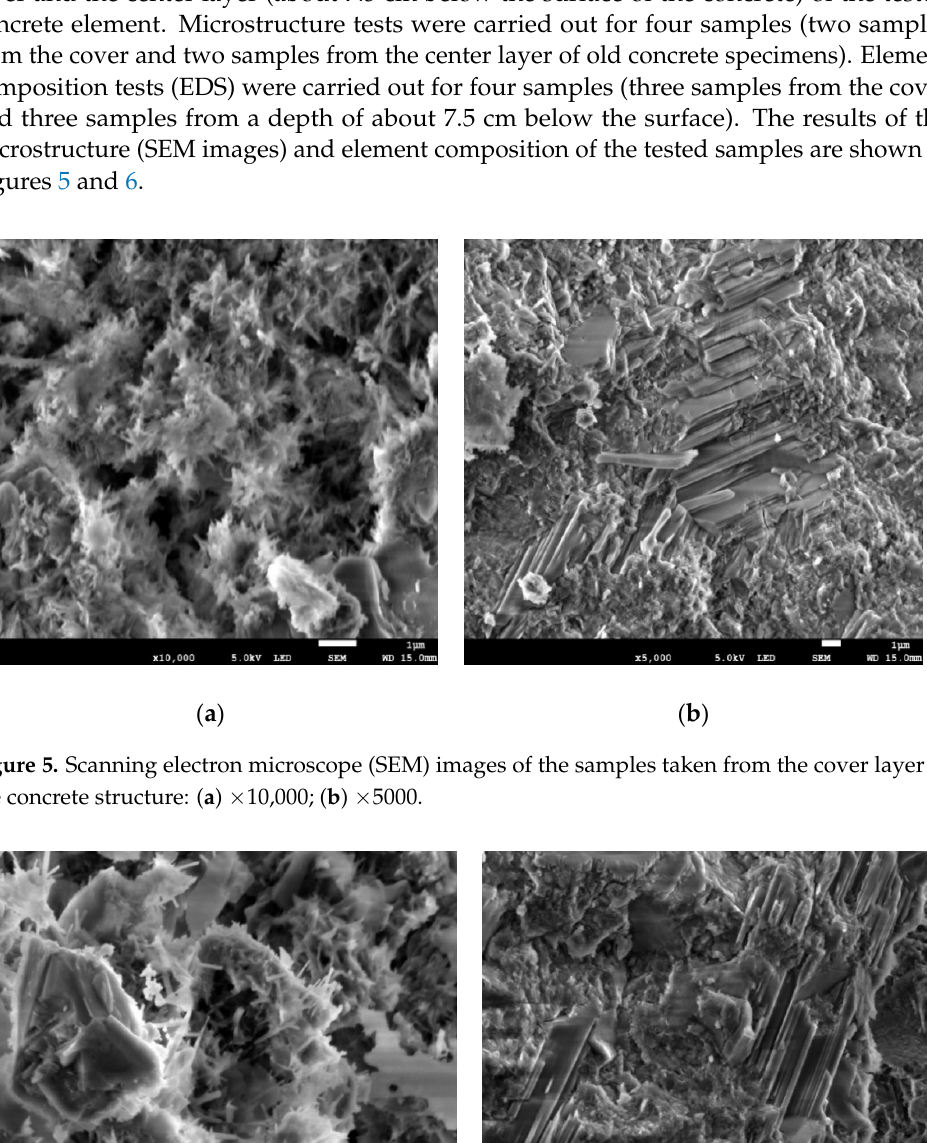
( b ) Figure 7. Energy-dispersion X-ray spectrometer (EDS) spectra of samples taken from the ( a ) cover layer; ( b ) center layer. Table 8. Element compositions of samples taken from the cover layer of the concrete structure as determined by EDS. Type of Element